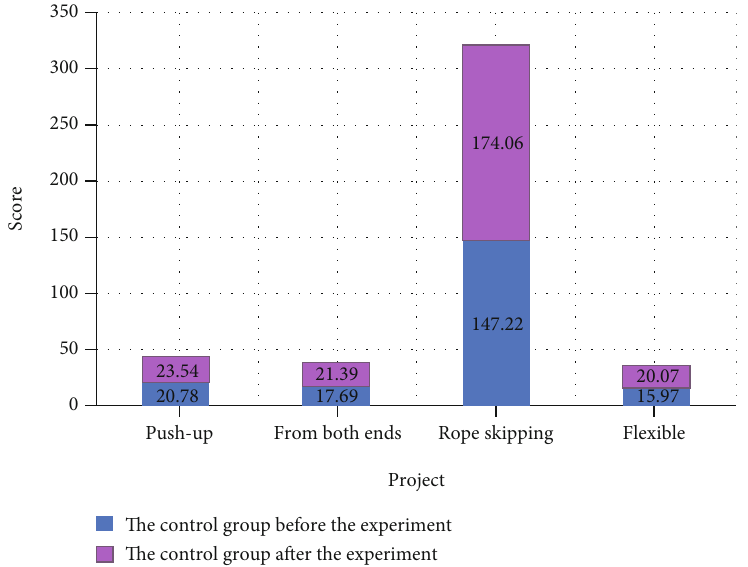
Figure 2: Physical fi tness statistics of the control